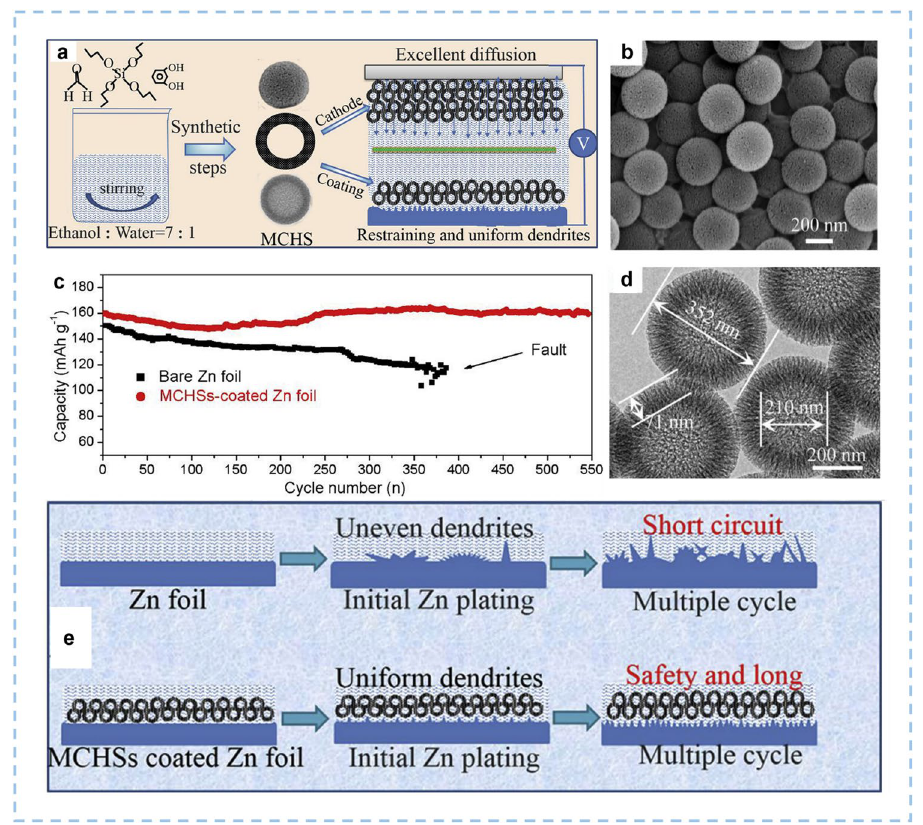
Fig. 5 The fabrication process and structure of MCHSs and comparison between bare Zn foil and Zn foil coated with MCHSs. a Sche- matic illustration for the synthesis of MCHSs. b , d SEM images of MCHSs. c Cycling performance of the MCHSs-coated Zn ∥ MCHSs and Zn ∥ MCHSs at 0.1 A g −1 . e Schematic illustrations of morphology evolution for bare and MCHSs-coated Zn foils during Zn